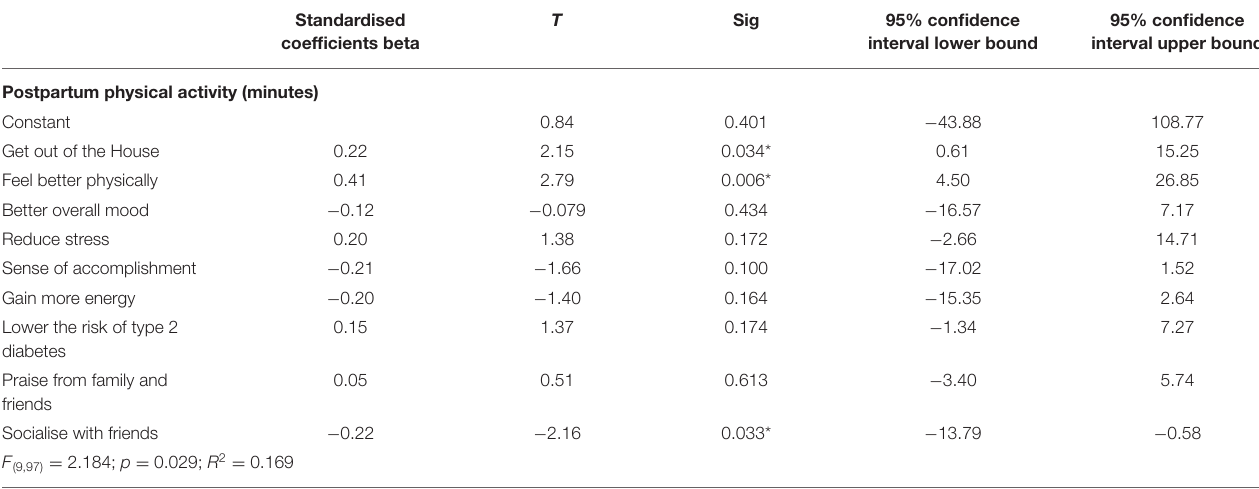
TABLE 5 | Linear regression analysis for postpartum physical activity against reported values for general